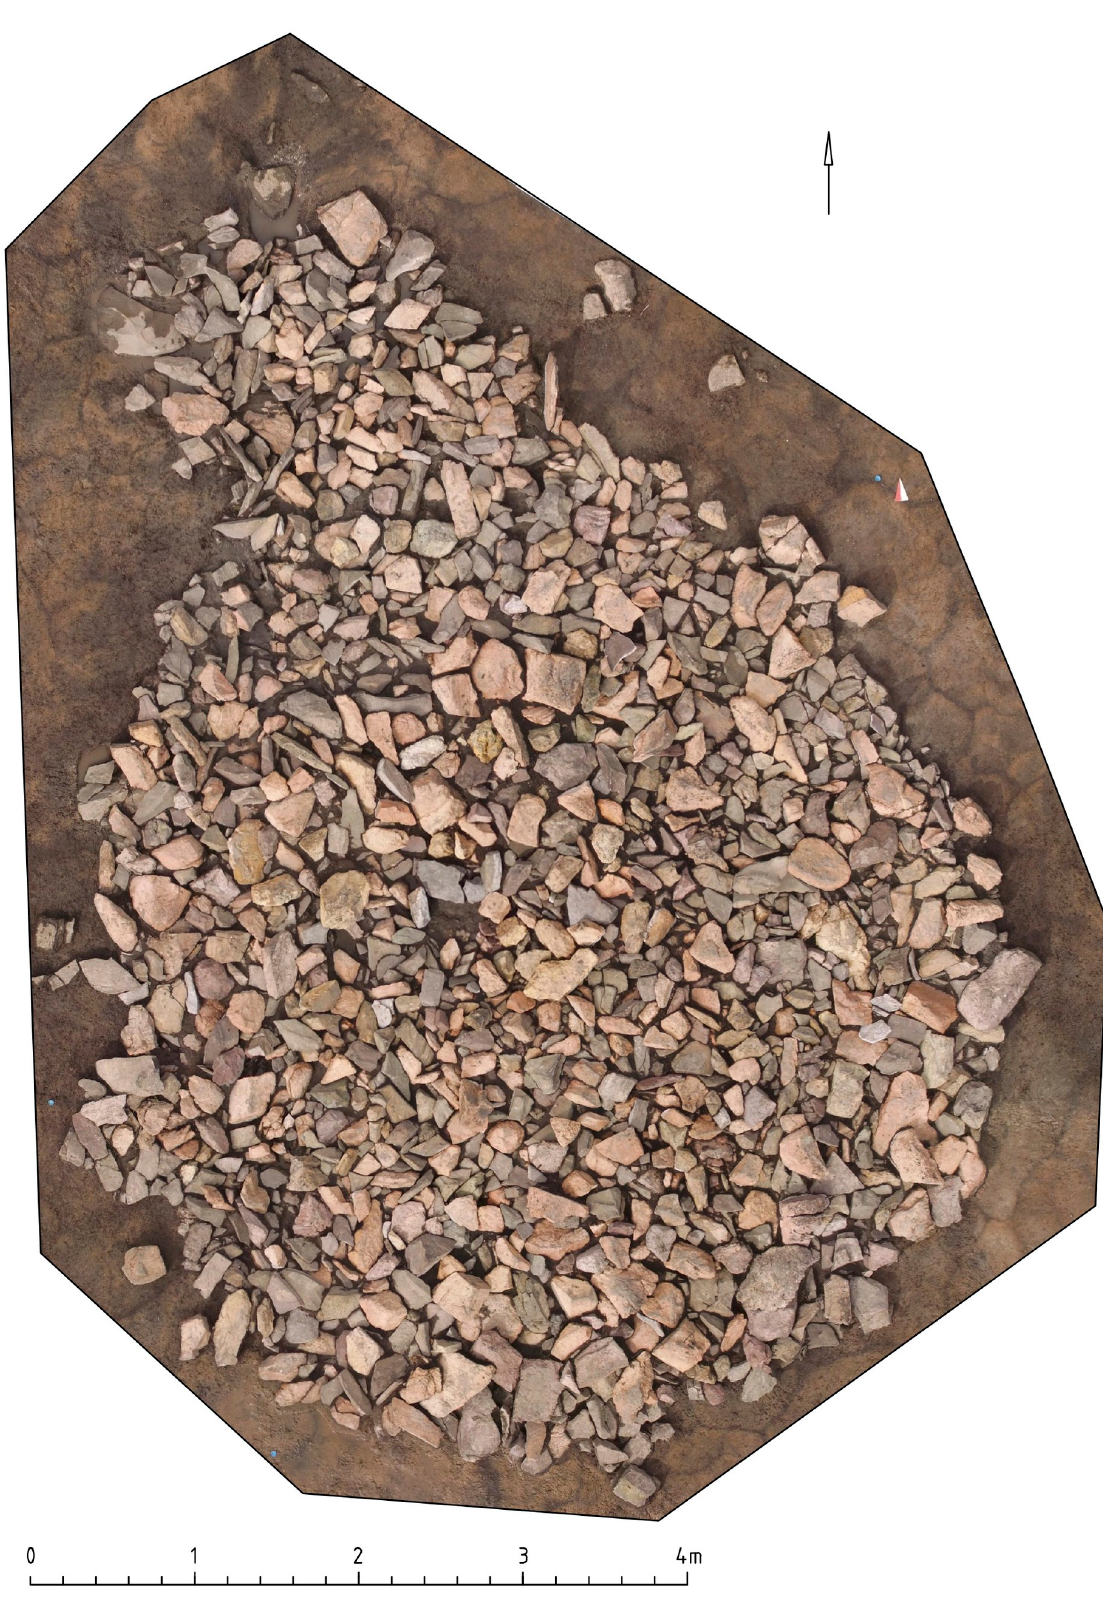
Fig 9. Tunnug 1. Orthophotograph of structure 15 before removing the stones covering the circle. https://doi.org/10.1371/journal.pone.0274537.g009 PLOS ONE | https://doi.org/10.1371/journal.pone.0274537 September 22,